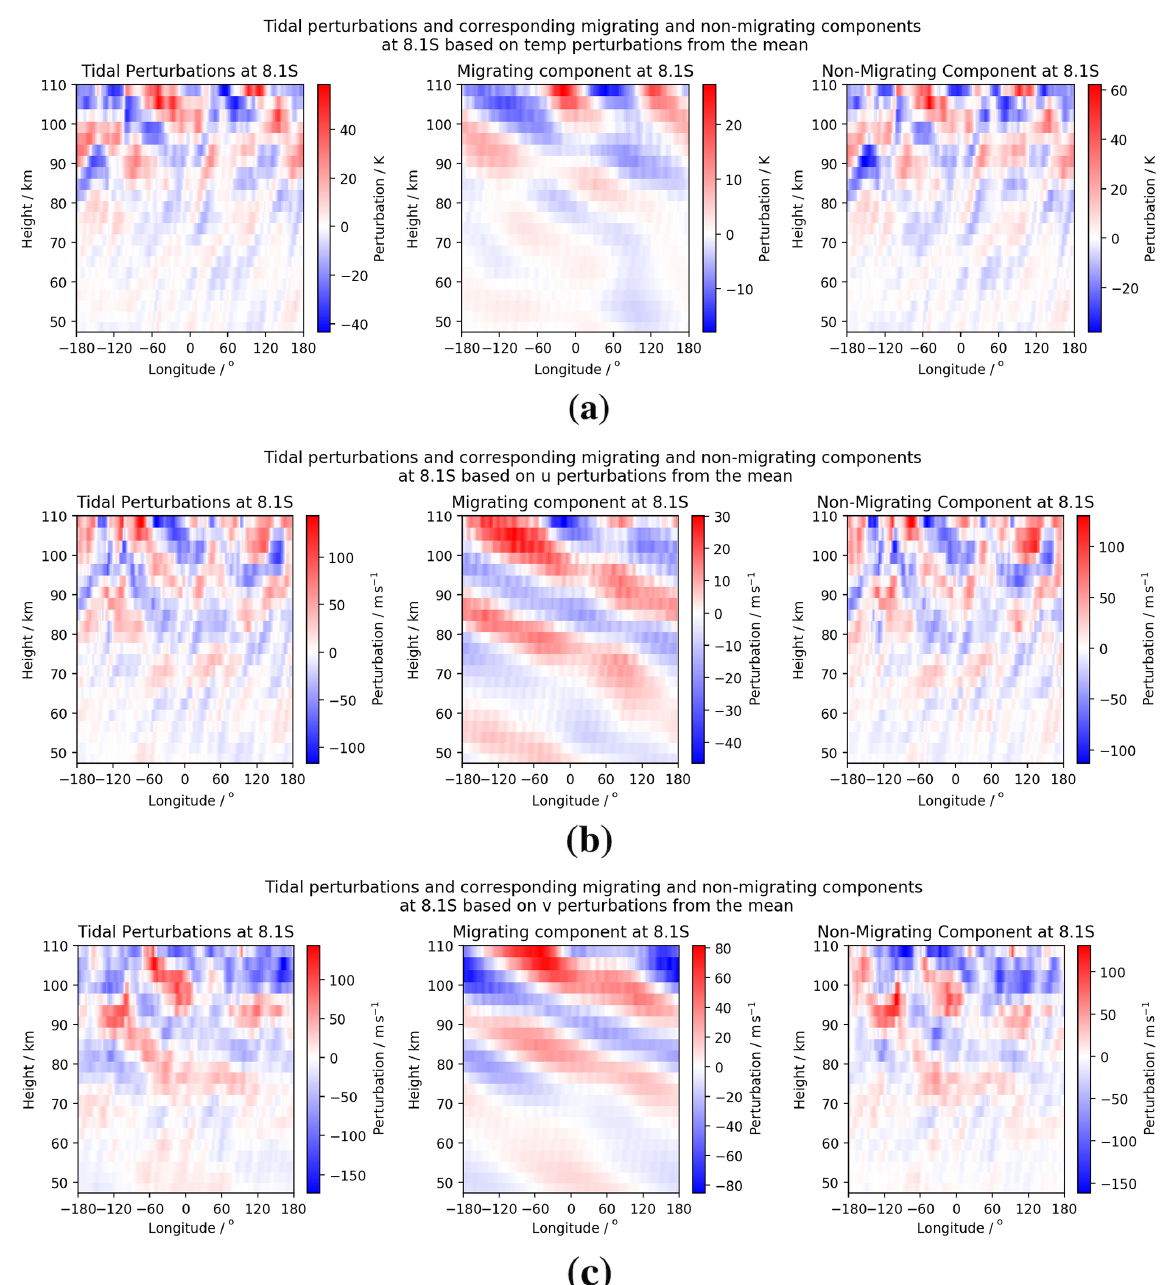
Figure 8. Longitude–height snapshot at 00:00UT on the first day of January at the equatorial latitude of Ascension Island (8 ◦ S) of tidal perturbations for (a) temperature, (b) zonal ( u ) winds, and (c) meridional ( v ) winds. The equatorial DW1 tide can be seen as the primary component of the migrating tide, with some presence of the SW2 tide in temperature. A superposition of several zonal wavenumbers is apparent in the non-migrating